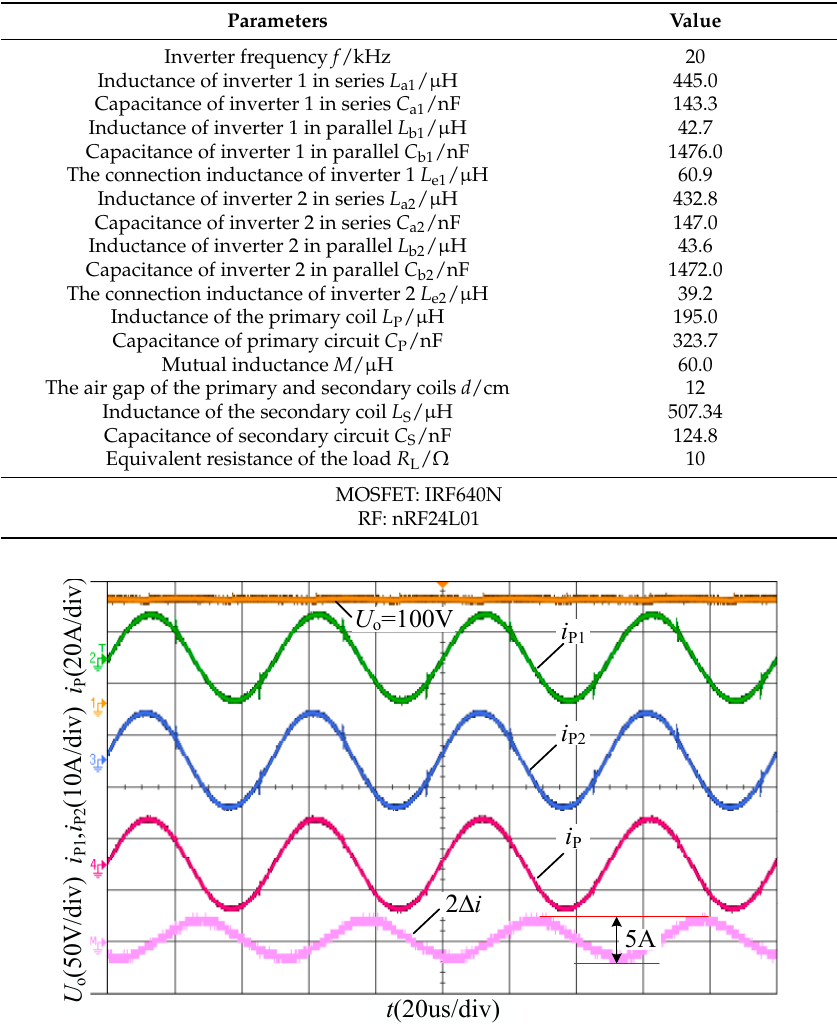
Δ ∆ i without the current phasor without the current phasor control. Figure 10. The waveforms of U o , i P1 , i P2 , i P and 2